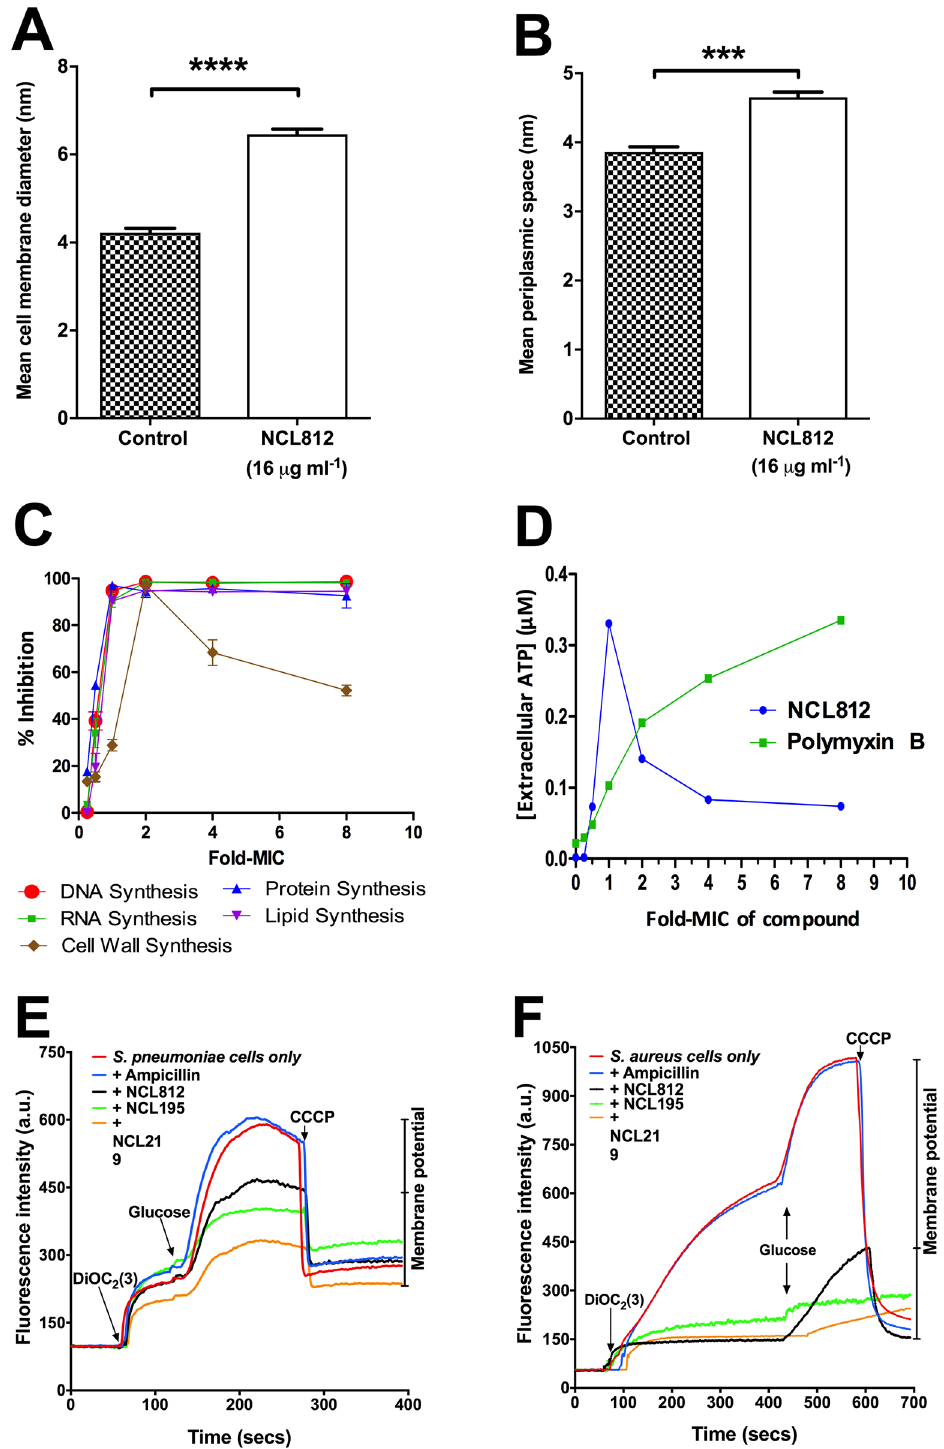
Fig 3. NCL812compounds exert their antibacterial action on the cell membrane of S . pneumoniae and S . aureus . ( Aand B ), S . pneumoniae strainD39exposedto 16 μ g/mlNCL812for 6 h exhibited significantly thickercell membranescomparedto untreatedsamples( A )( p < 0.0001;two-tailedunpaired t -test)anddisplayed significantly widerperiplasmic spacecomparedto untreatedsamples( B )( p < 0.001;two-tailedunpaired t -test. Datapresented are anexamplefrom 12 different bacterialcells,eachwith at least10 measurementsper bacteria